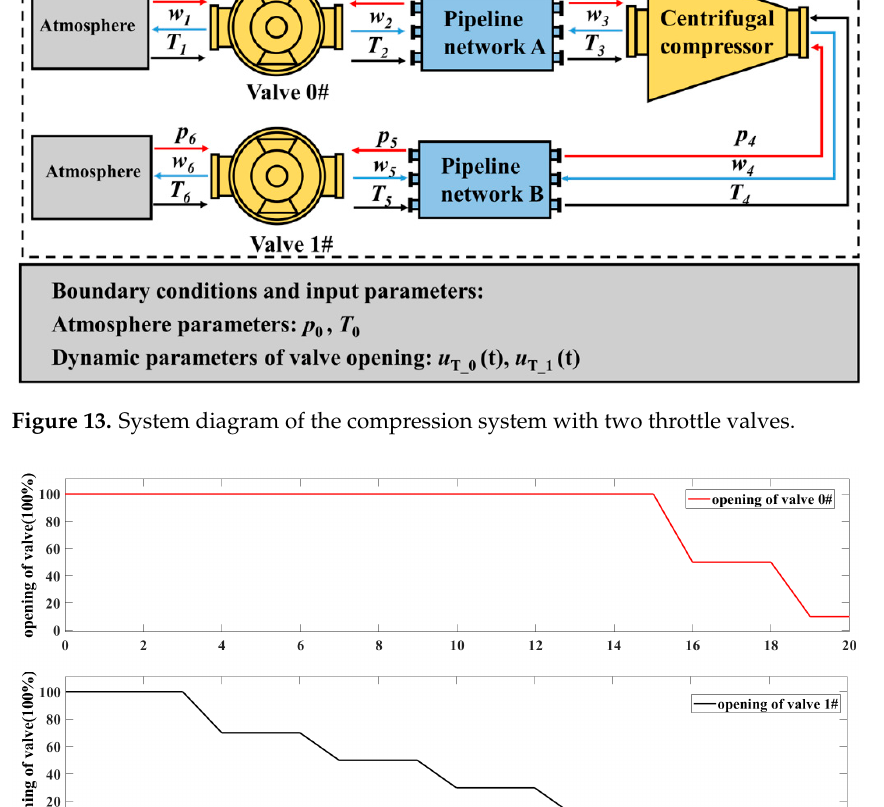
Figure 15. Compressor operating trajectory of the compression system with two throttle valves. Where the red solid line is the track of the migration of operating points, and the black dotted line is the compressor performance curve.